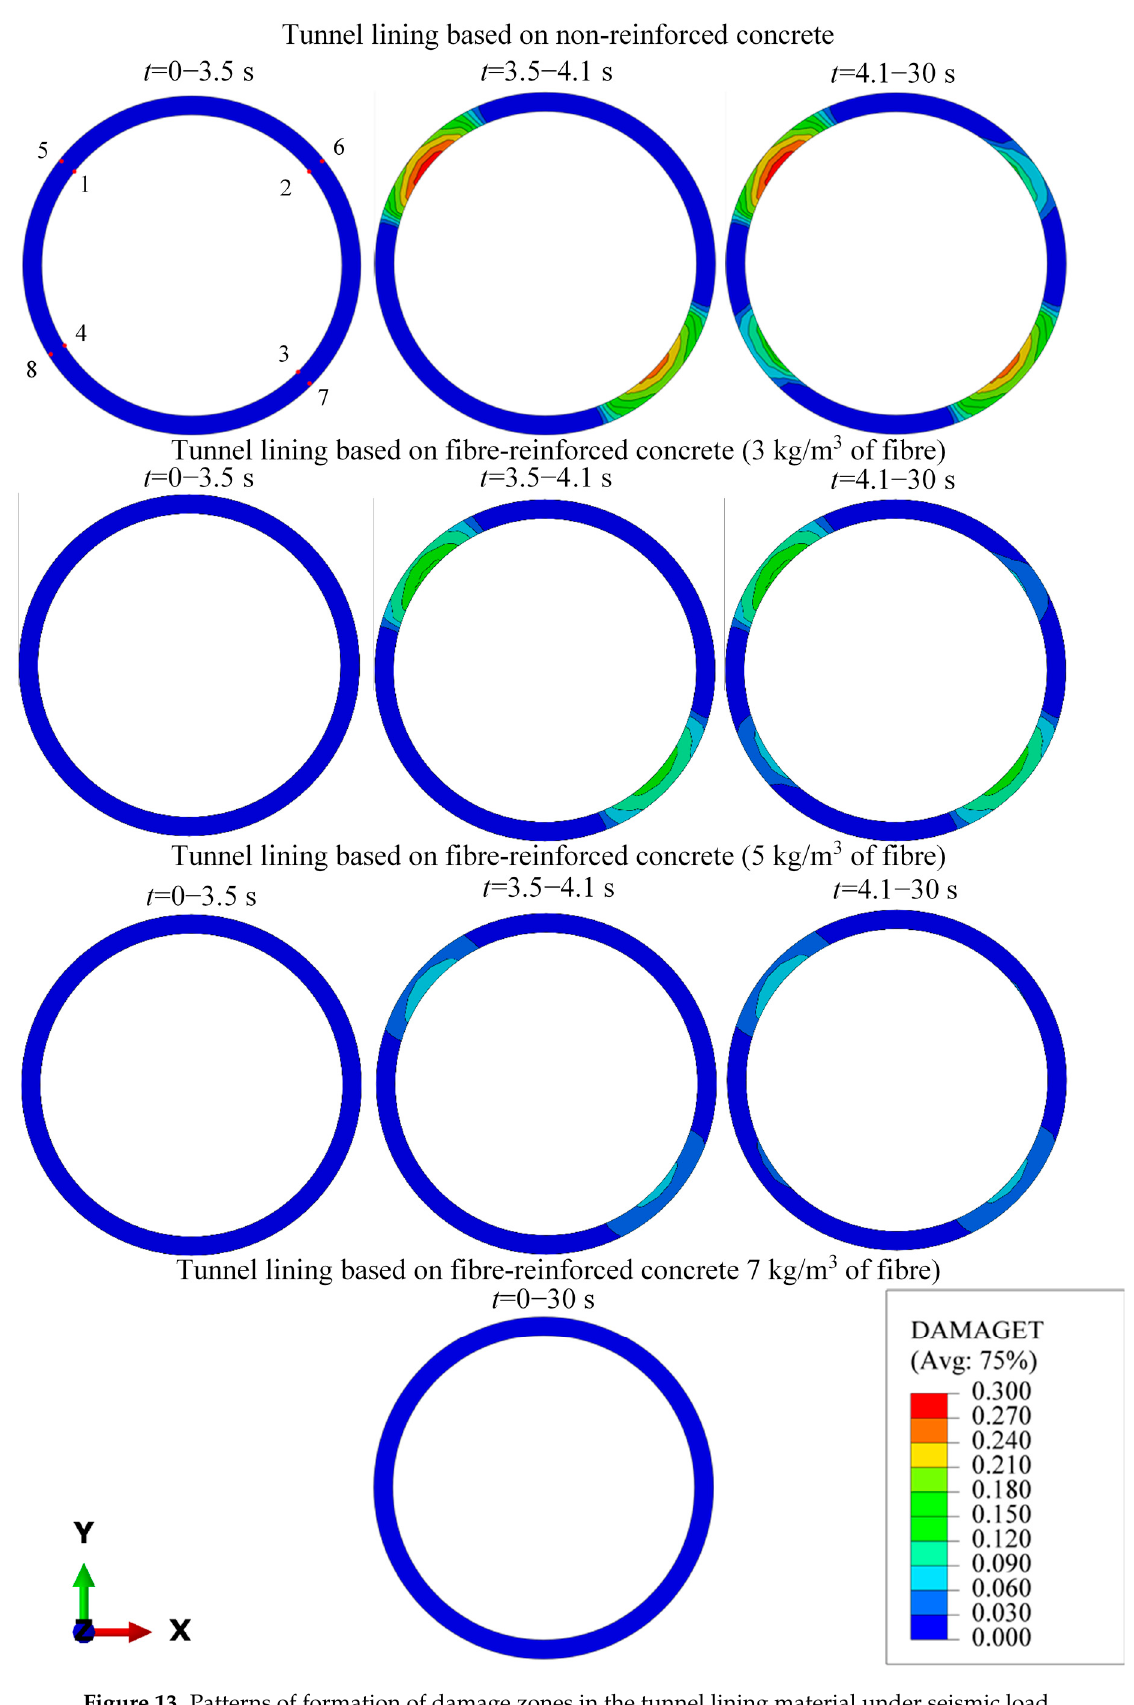
Figure 13. Patterns of formation of damage zones in the tunnel lining material under seismic load.